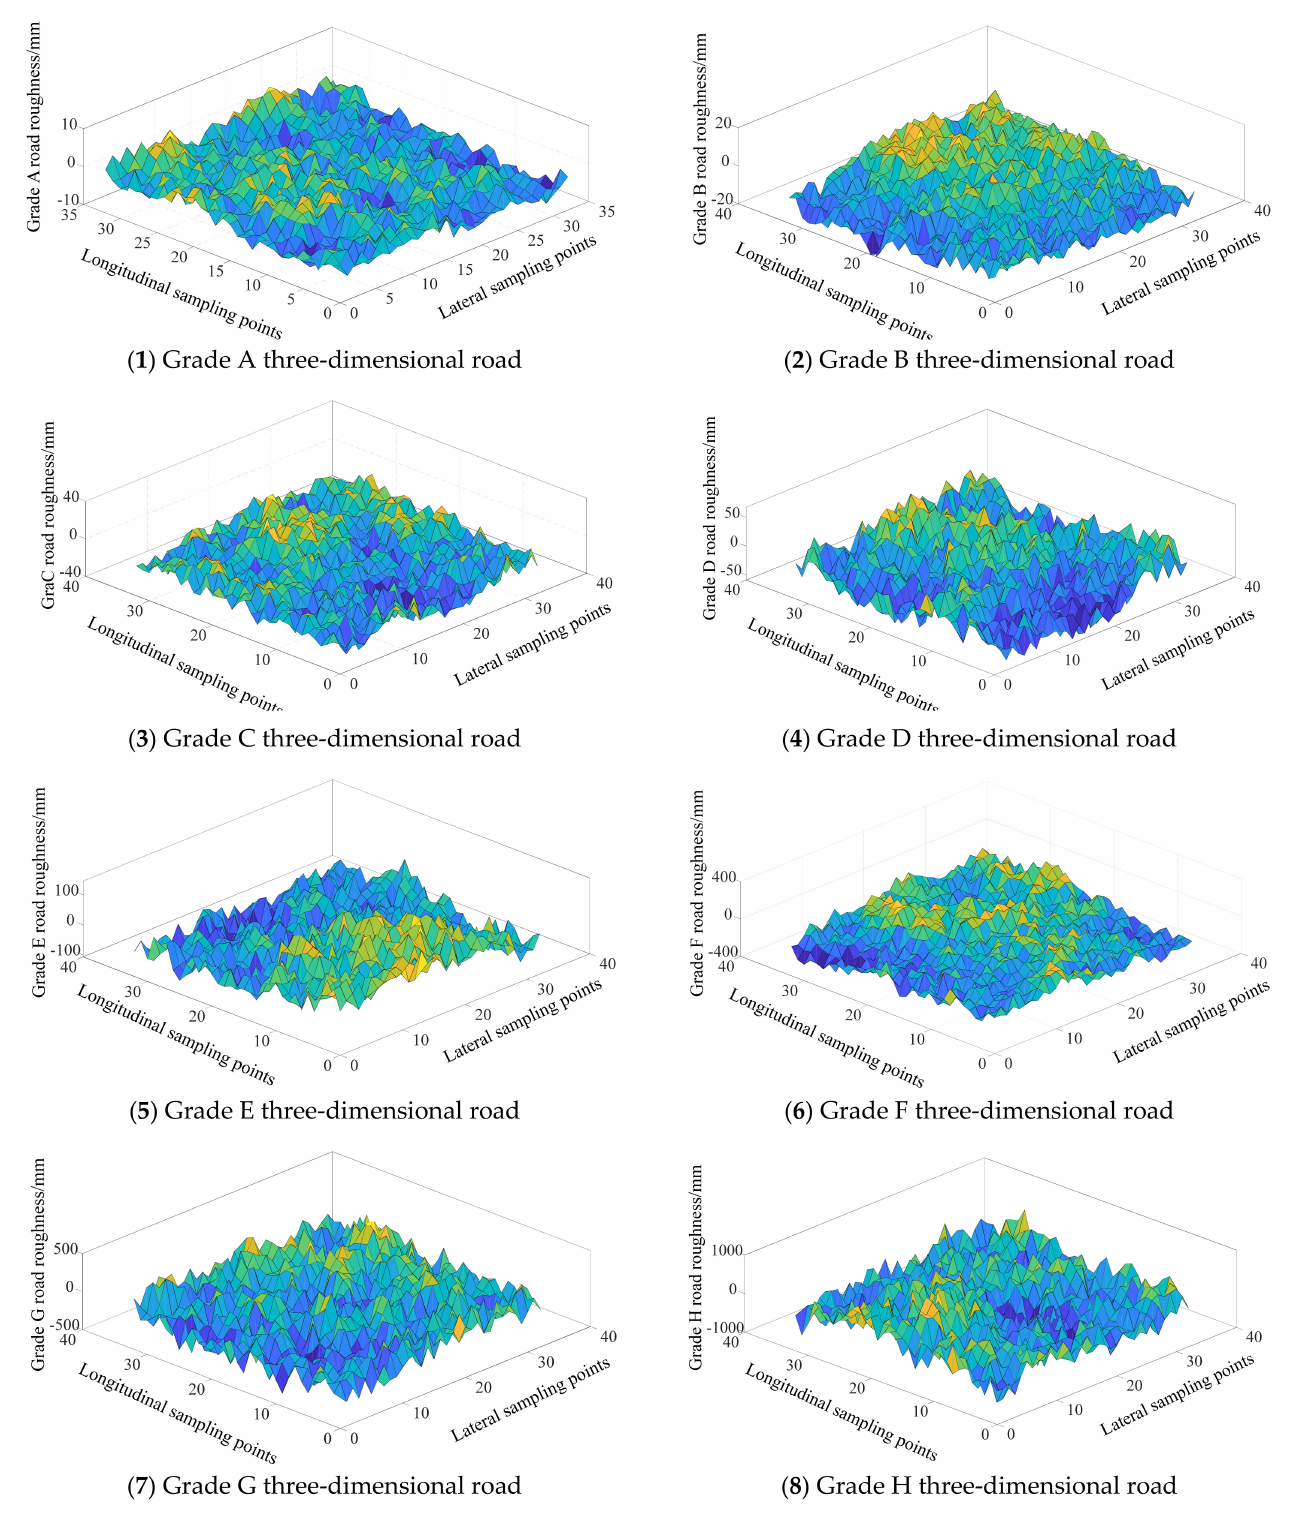
Figure 5. A-H-level 3D road reconstruction